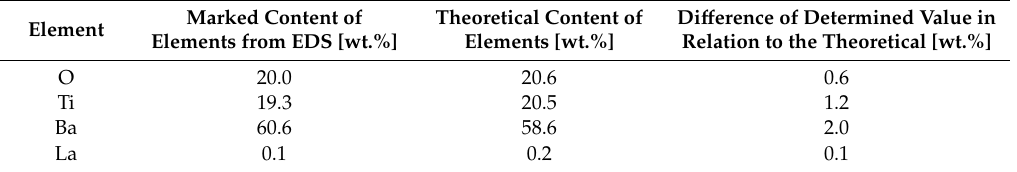
Table 2. Theoretical and experimental percentages of BLT4 ceramic elements.